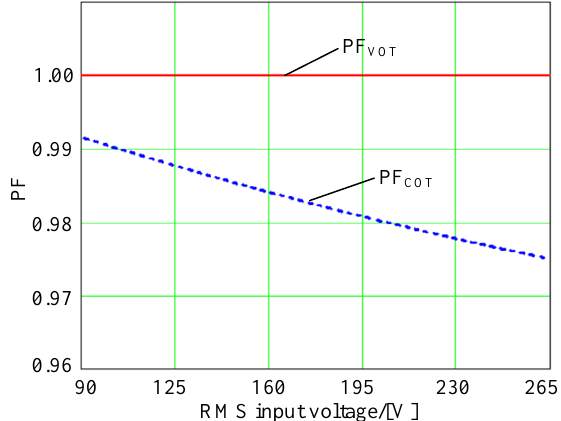
Figure 6. Comparison of the PF with different RMS input voltage .